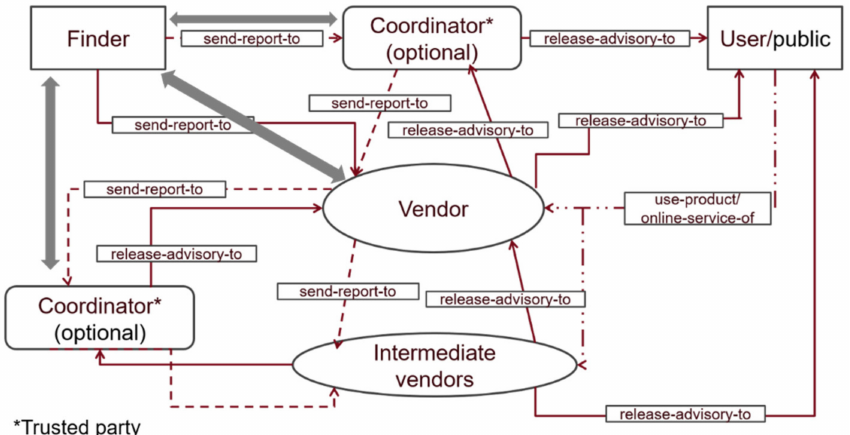
Figure 1. Approach of ISO/ICE 29147 and modification proposal for application in the automotive field indicated by bold